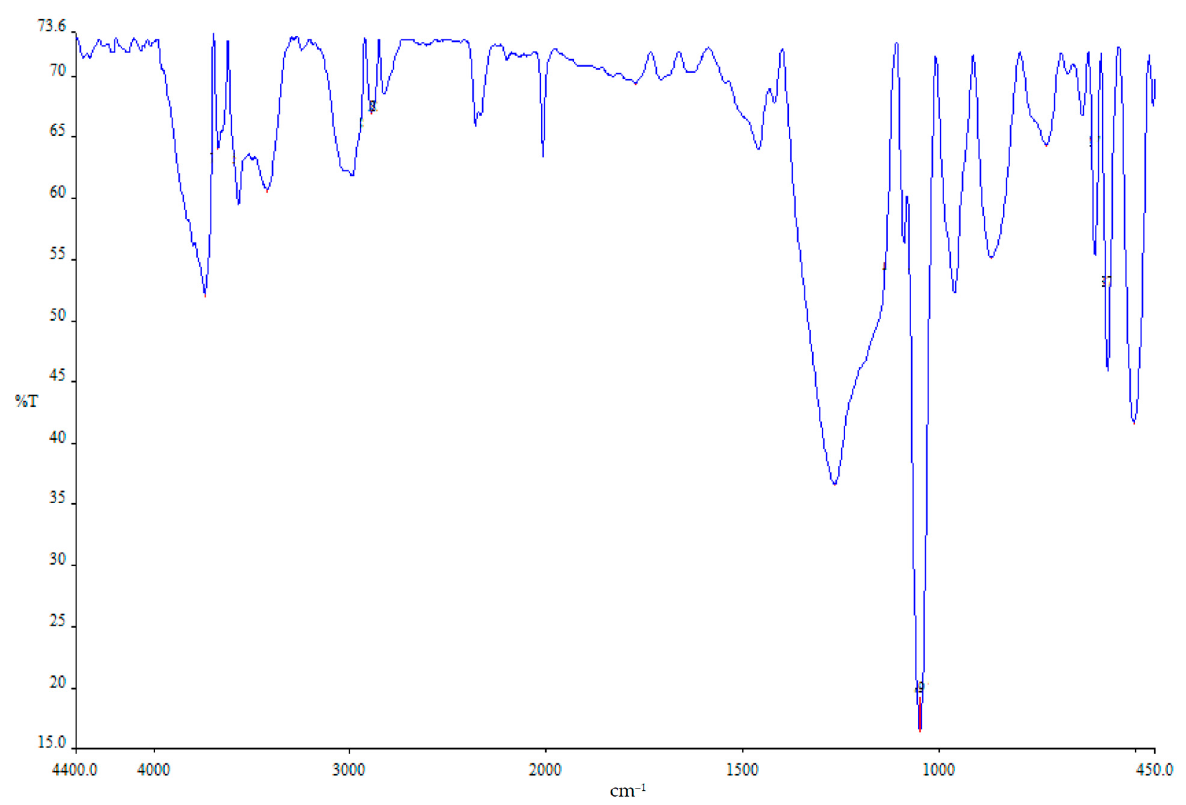
Figure 2. FT-IR spectrum of Co-Zr LDH.